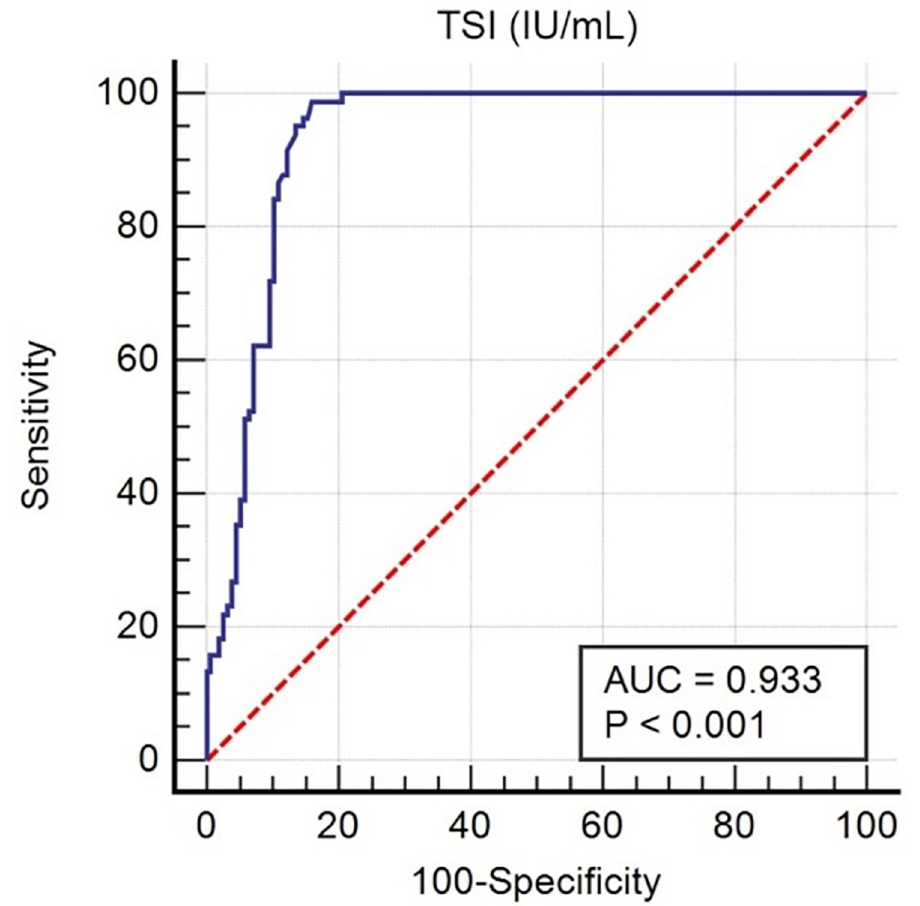
Fig 4. ROC curve analysis comparing TSI between GO vs. GD and controls. Cutoff value > 14.1 IU/mL Area under the ROC curve (AUC) = 0.933. (95% CI, 0.893–0.961), p < 0.0001. Positive percentage agreement (PPA)